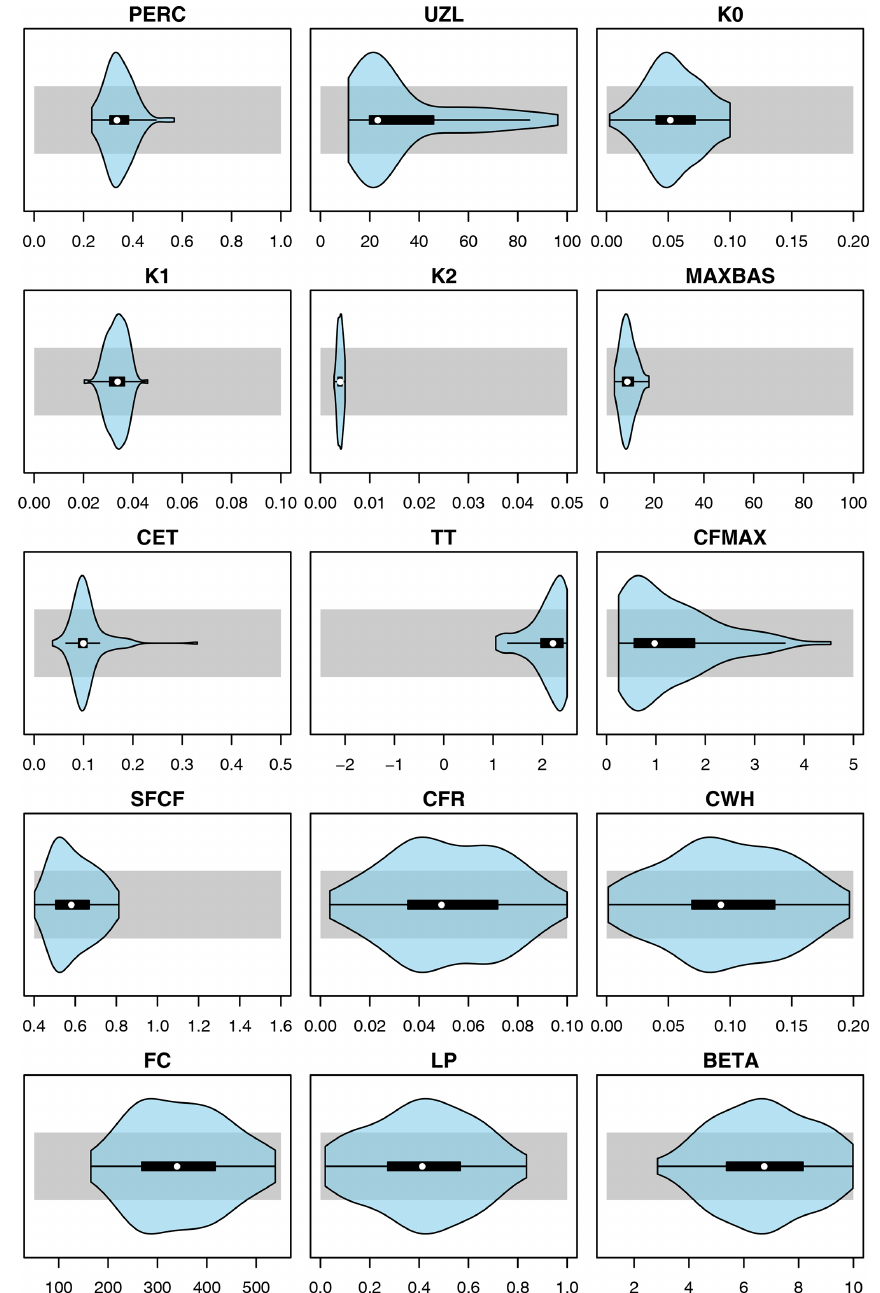
Figure C1. Violin plots (blue) summarizing 100 optimized parameter sets of the HBV model for the Dünnern at Olten catchment vs. initial calibration ranges (grey). Units as in Table